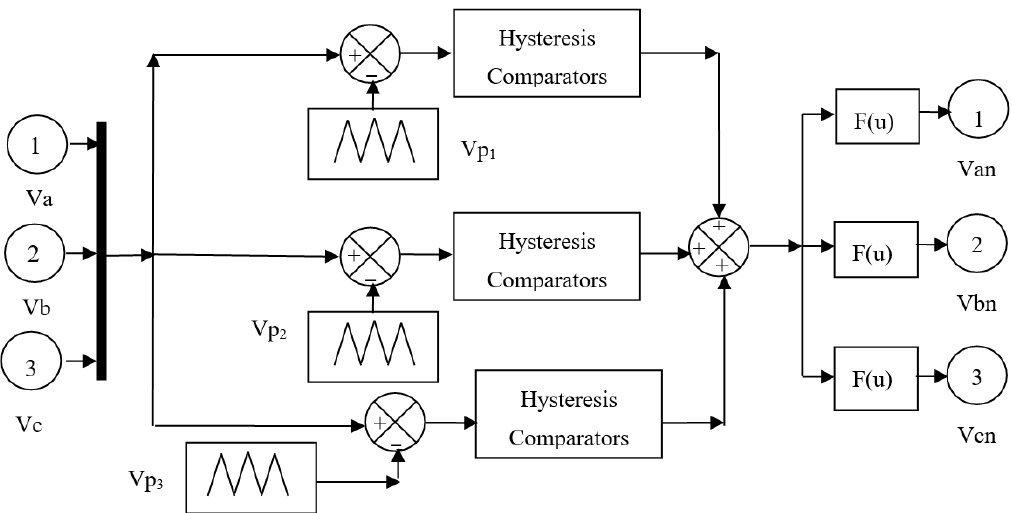
Figure 3. Conventional four-level PWM strategy.